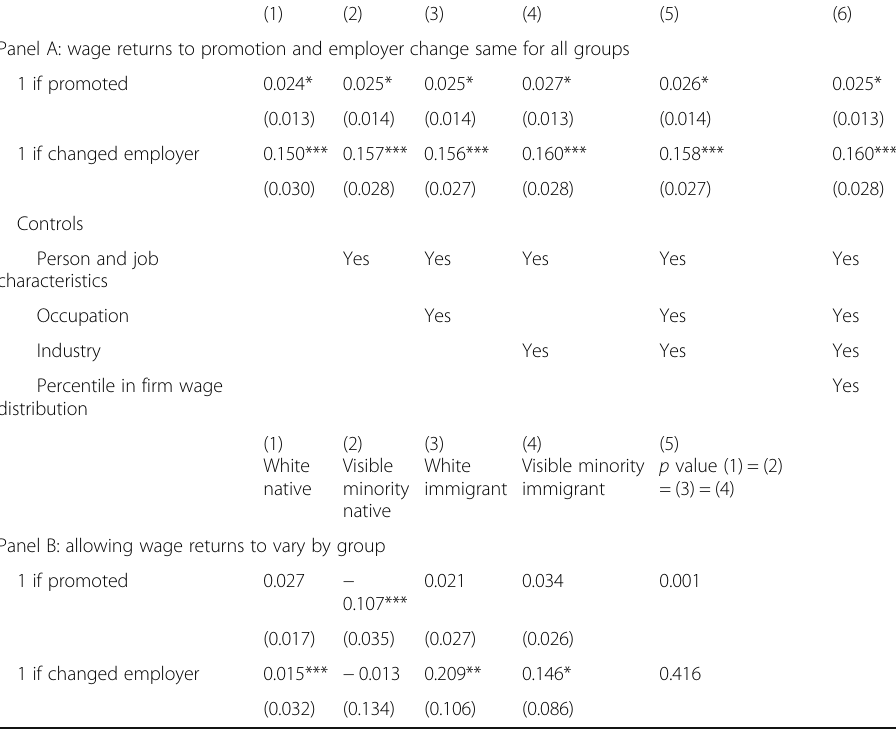
Table 6 Wage returns to promotion and employer change (1) (2) (3) (4) (5) (6) Panel A: wage returns to promotion and employer change same for all